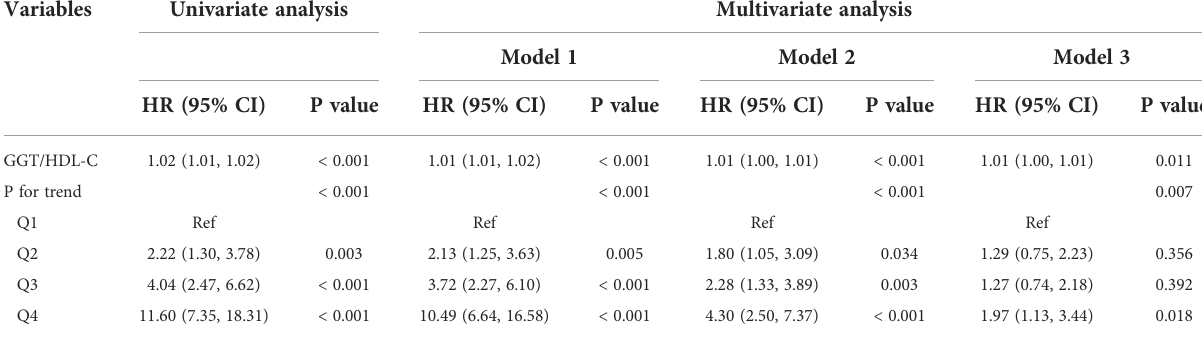
TABLE 2 Cox proportional hazards regression analysis for the association between GGT/HDL-C ratio and incident